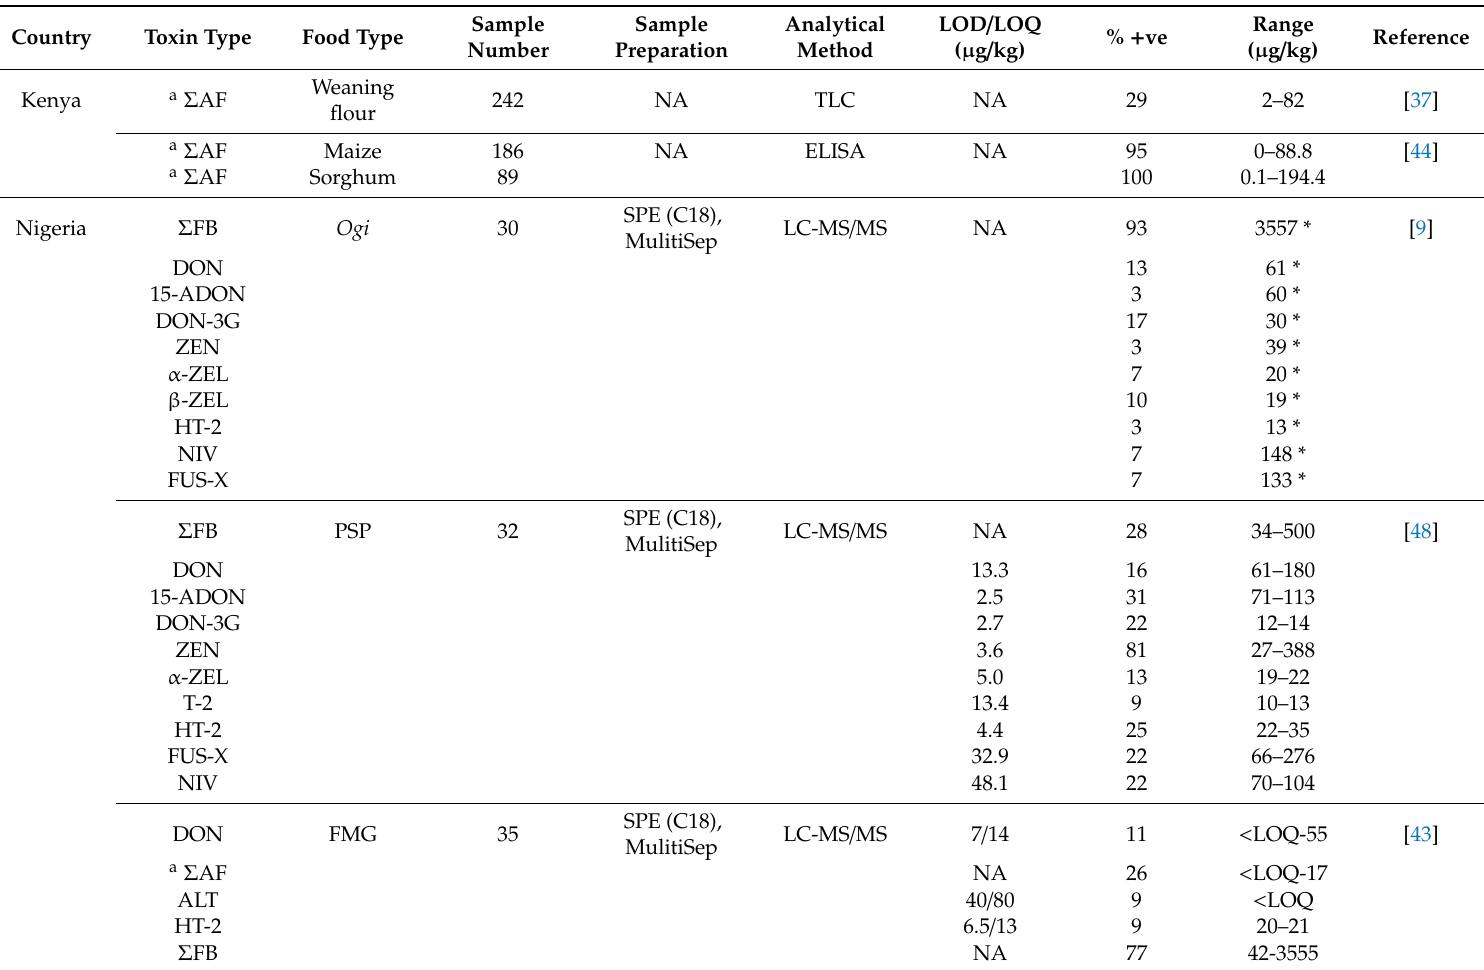
Table 1. Mycotoxin contamination of cereal- and oilseed-based complementary foods originating from sub-Saharan Africa.